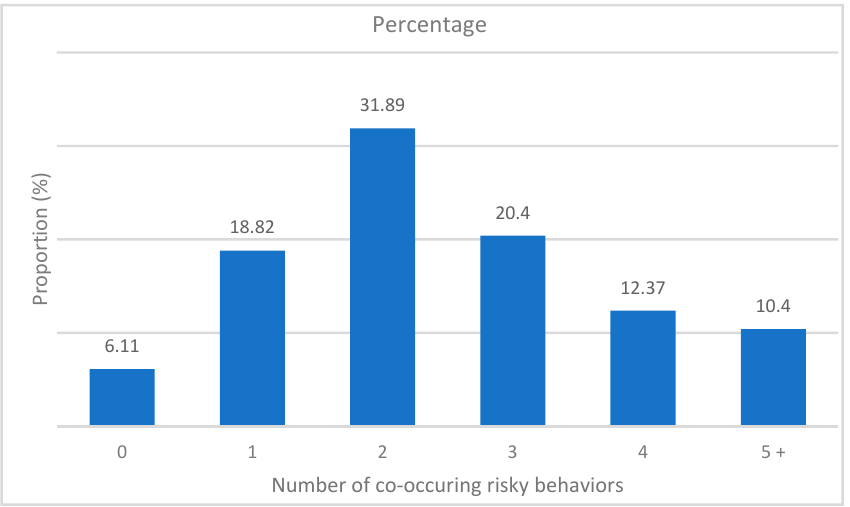
Figure 1. Prevalence of the number of co-occurring risky behaviors among adolescents aged 11–18 in Mauritius, 2017.